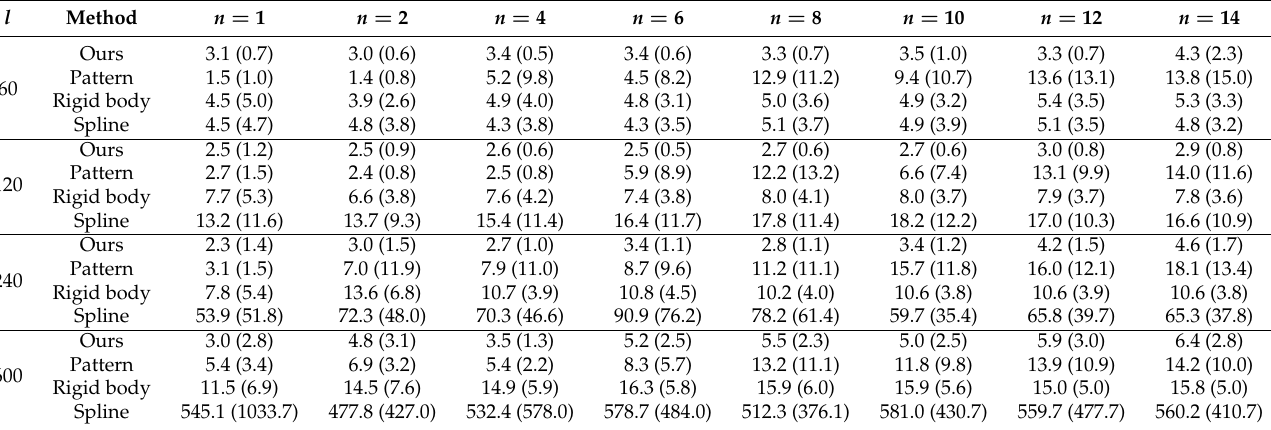
Table 6. Performance of the four gap filling methods (ours, pattern fill, rigid body fill and spline fill) in each tested condition. Mean (standard deviation) of RMSE is presented in cm.